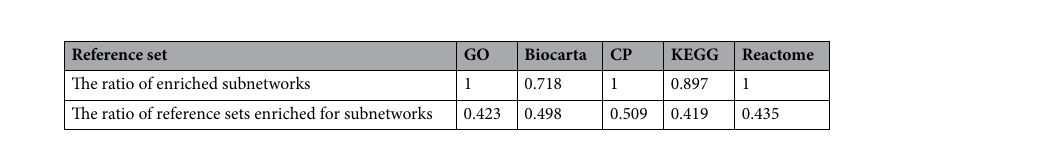
Table 4. The result of pathway enrichment tests in detected epigenetic